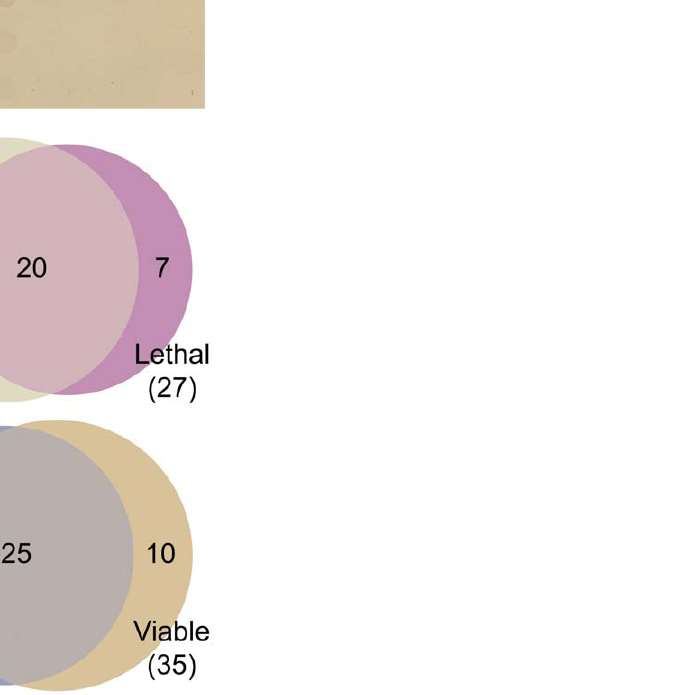
Figure 2. Thermodynamic destabilization of the histone octamer correlates with lethal phenotypes in yeast. A , Yeast strains bearing H3-H3 9 interface mutations predicted to cause thermodynamic destabilization of the nucleosome are lethal. The WZY42 histone shuffle strain transformed with the wild-type or indicated H3 mutant was plated in 10-fold serial dilution on selective synthetic complete-Trp media with (right plate) or without (left plate) 5-Fluoroorotic acid (5-FOA). B , Broad analysis of growth phenotypes and their relation to predicted nucleosome stability reveal significant difference in DD G between viable and lethal mutants. Box plots are shown, which represent range between 25 and 75 percentile values. Horizontal line inside the box represents the median. Whiskers correspond to values nearest to 1.5 times the interquartile range and outliers are represented as circles. P-value is obtained from two sample, single-tailed t-test. The dashed-line represents DD G of 3kcal/mol, used to distinguish between stabilizing and destabilizing mutants. C , Venn diagram showing the significant overlap that exists between lethal and destabilizing mutants found in H3 and H4 for interface and buried residues. Compilation of lethal mutant results is from HistoneHits database. The numbers inside the Venn diagram refer to number of mutations belonging to the corresponding categories. D , Venn diagram showing the significant overlap that exists between viable and stabilizing mutants found in H3 and H4 for interface and buried residues. Compilation of lethal mutant results is from HistoneHits database. The numbers inside the Venn diagram refer to number of mutations belonging to the corresponding categories.